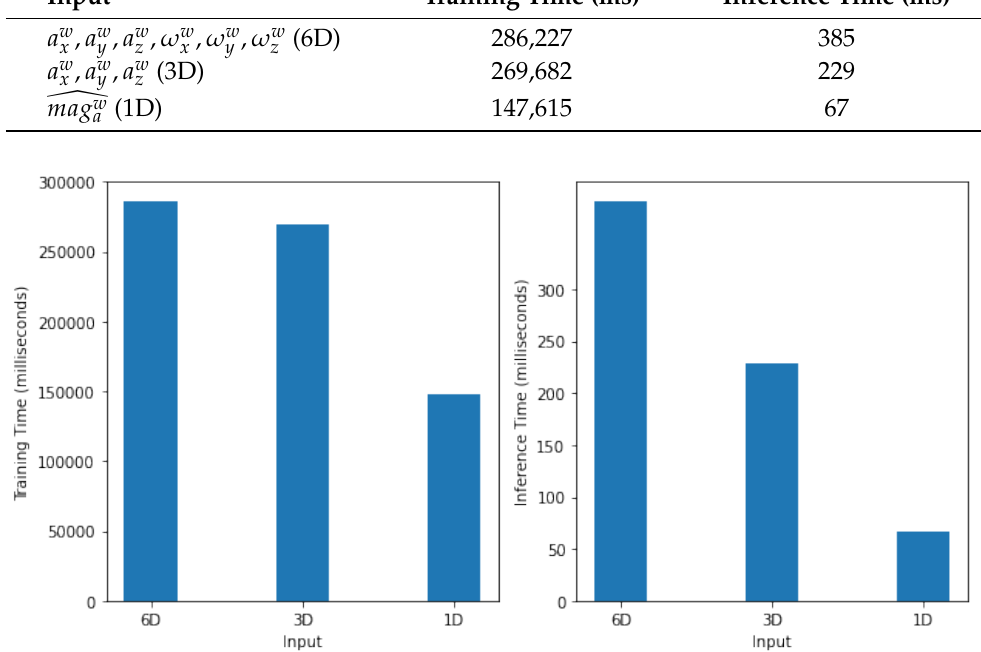
Figure 12. Computation time required by the proposed model for the training (left) and in- ference (right) under different sizes of input signals, i.e., 1D ( ( a w x , a w y , a w z , ω w x , ω w y , ω w z ). With a 1D input size, the model is trained in 147,615 ms whereas the inference took only 67